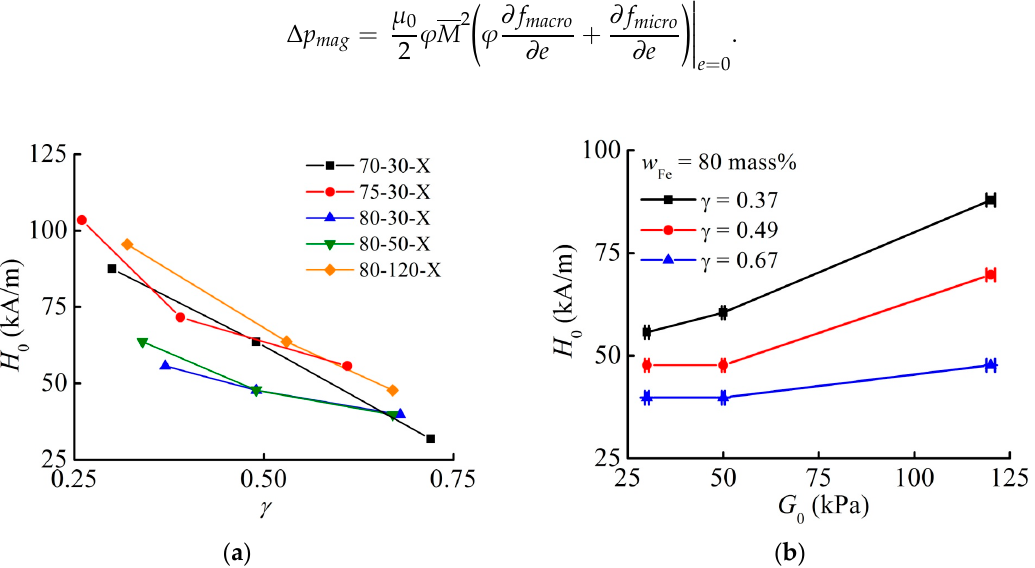
H on the aspect ratio  for different MAE 0 H on the shear modulus G for the fixed iron 0 0